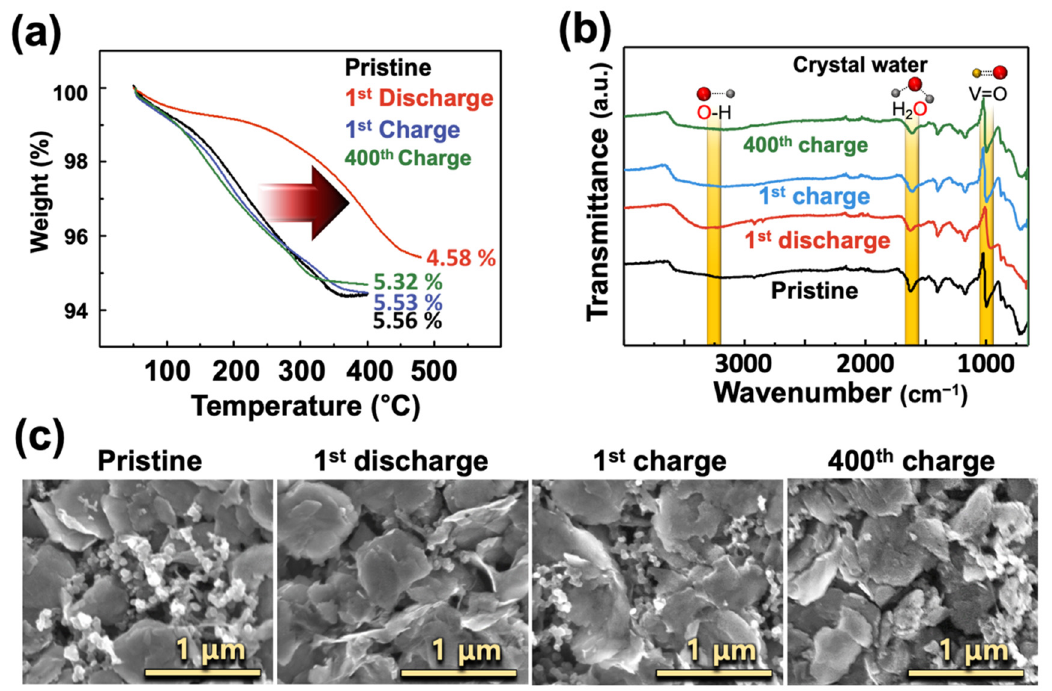
Figure 3. ( a ) TG analyses under nitrogen atmosphere, ( b ) FTIR spectra, and ( c ) SEM images of pristine FVO and FVO after first discharge cycle, first charge cycle, and 400th charge cycle.